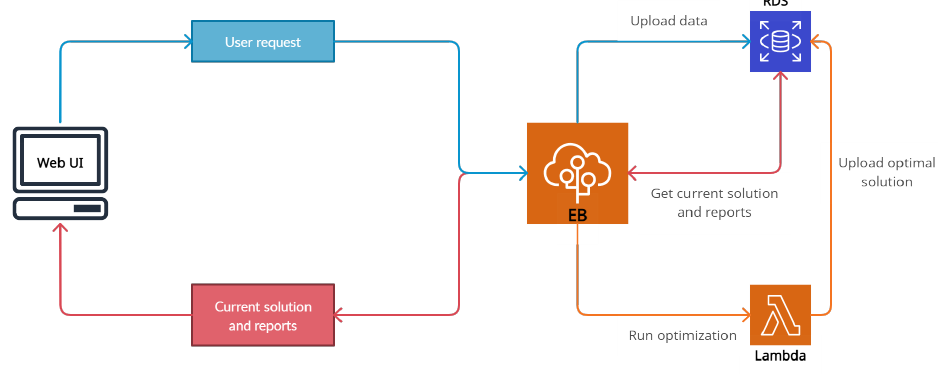
Figure 6. AWS architecture for the DSS. It includes the following services: (1) a web application deployed through AWS Elastic Beanstalk (EB), (2) an AWS Lambda function that runs the optimization procedure, and (3) an AWS relational database (RDS) that stores all input and output data. The main functionality for the user consists of (1) uploading data (parameters, values, and AB information) to the database, (2) running the optimization procedure (via a Lambda function that subsequently uploads the optimal solution to the database), and (3) requesting the latest optimal solution and related reporting. All of the requests are made through a user-friendly web interface (Web UI).